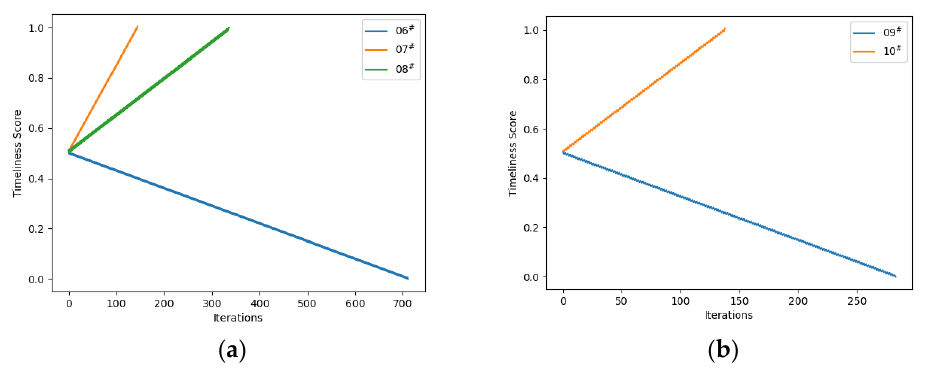
Figure 5. Change trend of score value when periodic data update fluctuates around the set time.